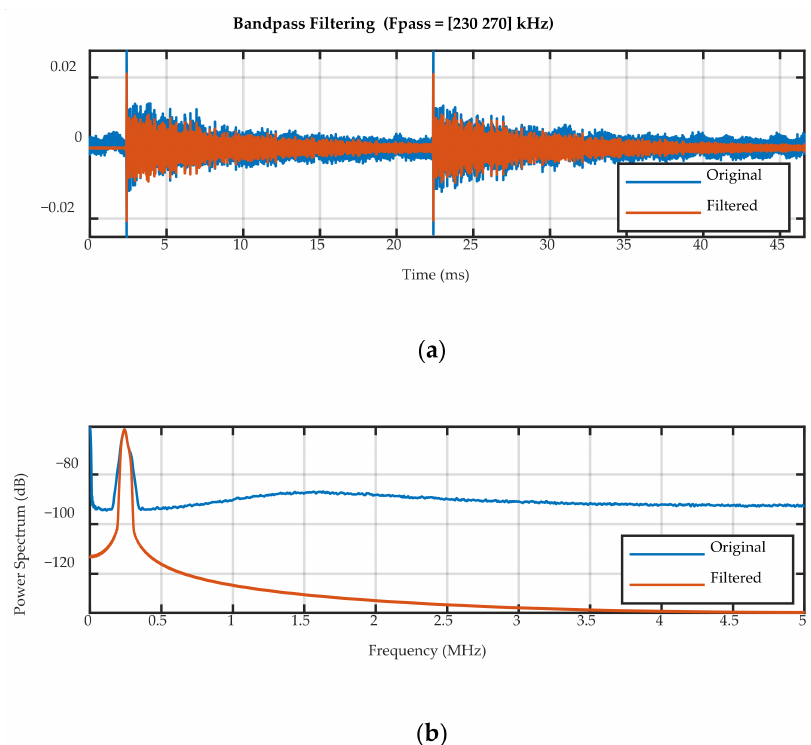
Figure 4. Bandpass filtering of a 250 kHz UGW acquired by the 10-mm FBG: ( a ) the unfiltered and filtered (unaveraged) 2 burst signal, and ( b ) the power spectral density of the unfiltered and filtered signals.